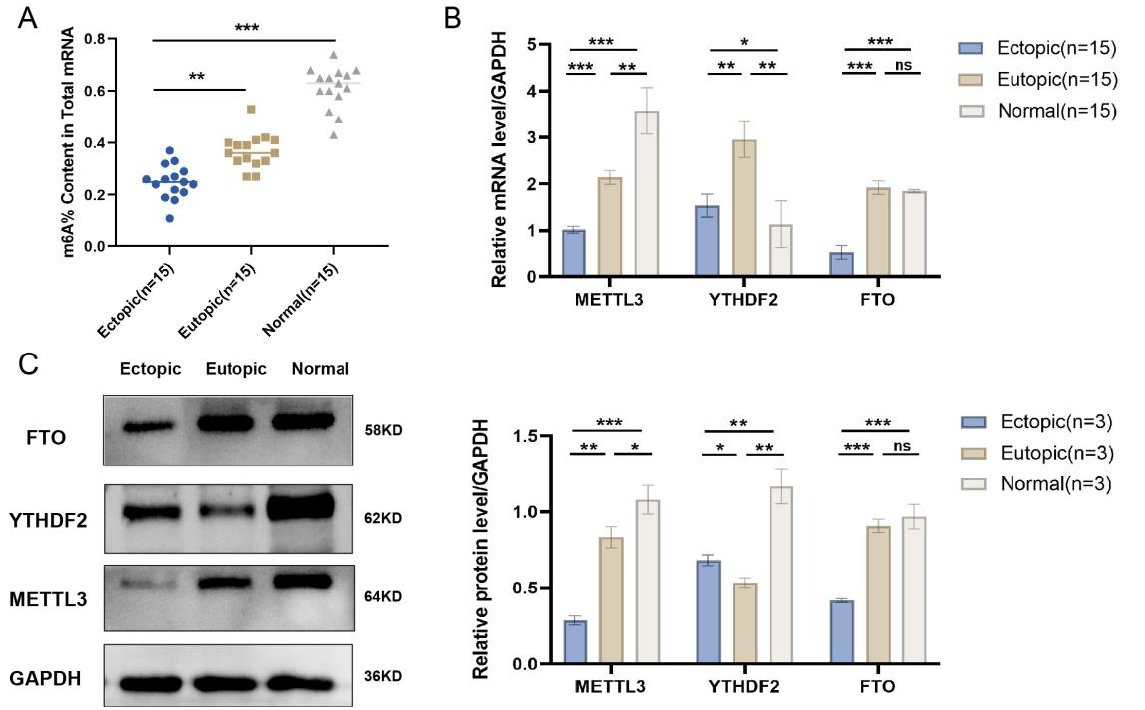
Figure 8. Experimental validation of key m6A regulators in tissues. ( A ) Each m6A level detected by m6A quantity assay in Ectopic, Eutopic and Normal groups. ( B , C ) The mRNA expression levels by RT-qPCR ( B ) and protein expression levels by WB ( C ) of METTL3, YTHDF2 and FTO in Ectopic, Eutopic and Normal groups. These results were presented as the mean ± SDs. ns, p ≥ 0.05; *, p < 0.05; **, p < 0.01; ***, p < 0.001.